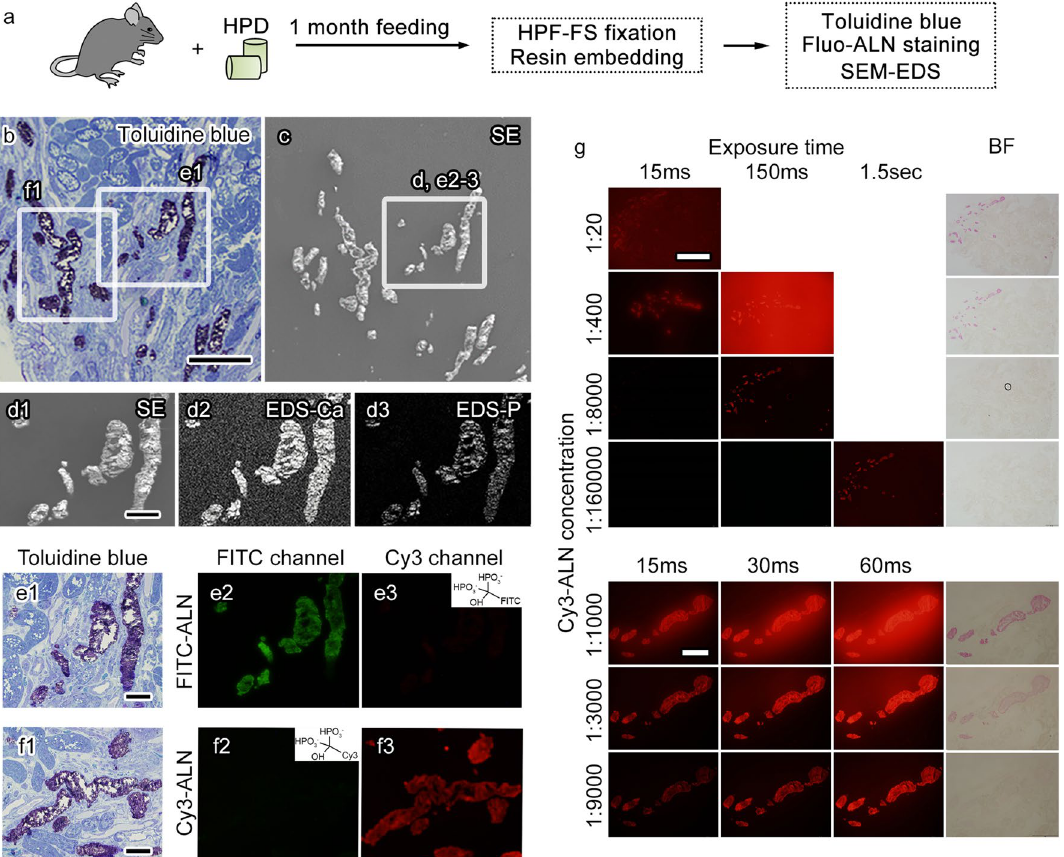
Figure 2. Histological detection of calcium phosphate particles (CaPs) by staining with fluorescence- conjugated alendronate derivatives (Fluo-ALN). A scheme of experiments ( a ) indicating that the semi-thin sections of kidney tissues prepared by high-pressure freezing followed by freeze substitution (HPF-FS) and embedded in resin are stained with toluidine blue or Fluo-ALN and observed with light microscopy or scanning electron microscopy (SEM) with energy-dispersive X-ray spectroscopy (EDS). Images of serial sections stained with toluidine blue and observed using light microscopy ( b ) or observed with SEM–EDS ( c , d ) for a secondary electron image ( d1 , SE) or signals of calcium ( d2 , EDS-Ca) and phosphorus ( d3 , EDS-P). The marked areas ( b ) are magnified ( e1 , f1 ). The marked areas ( c ) are magnified ( d , e2 , e3 ) in the same section with FITC-conjugated Fluo-ALN (FITC-ALN, inset of e3 ). Light microscopy images indicate that the CaPs with metachromasia ( e1 ) are observed in the green channel ( e2 ) although not in the red channel ( e3 ) in the staining with FITC-ALN (inset of e3 ). The CaPs with metachromasia ( f1 ) are observed in the red channel ( f3 ) although not in the green channel ( f2 ) in the serial sections stained using Cy3-conjugated Fluo-ALN (Cy3-ALN, inset of f2 ). The resin sections stained with Cy3-ALN at various concentrations are observed with light microscopy with the variable exposure time ( g ). Values on the left side indicate the Cy3-ALN concentrations. Scale bars: 200-μm ( b ), 50-μm ( d – f ), 500-μm ( g , upper images), and 100-μm ( g , lower